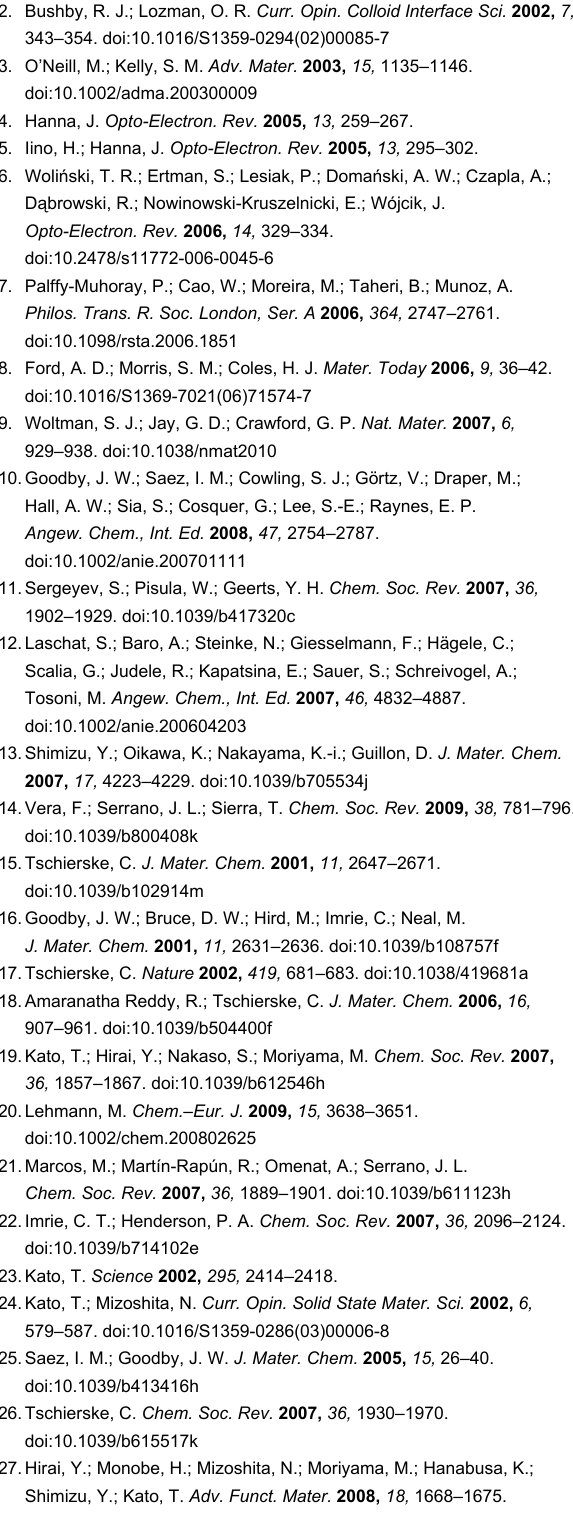
Figure 6: Molecular structure of a gallium(III) mesogen.